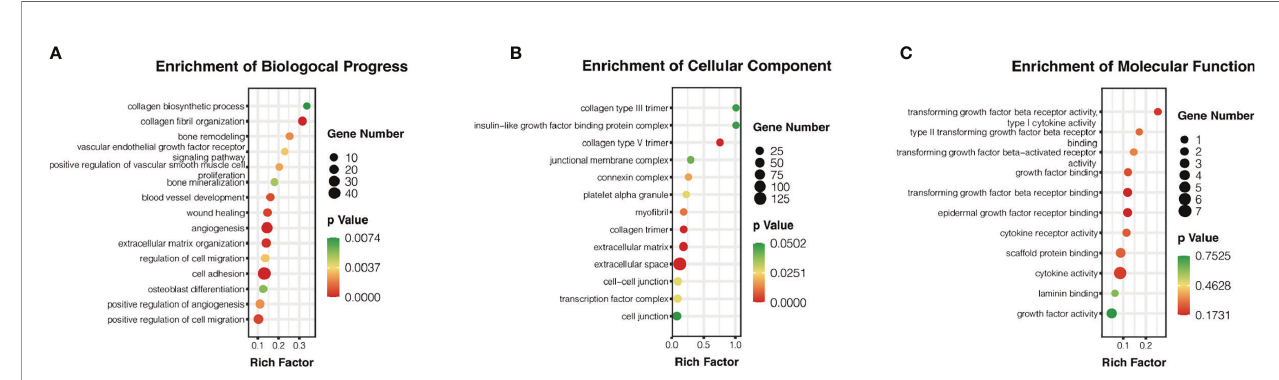
FIGURE 3 | The potential biological functions of NPVs were analyzed by Gene Ontology (GO). (A) is biological process analysis, (B) is cell component analysis, and (C) is molecular function analysis. The pathways which are shown in the fi gure all help promote tissue repair. Biological processes are listed in the fi gure with their respective gene numbers